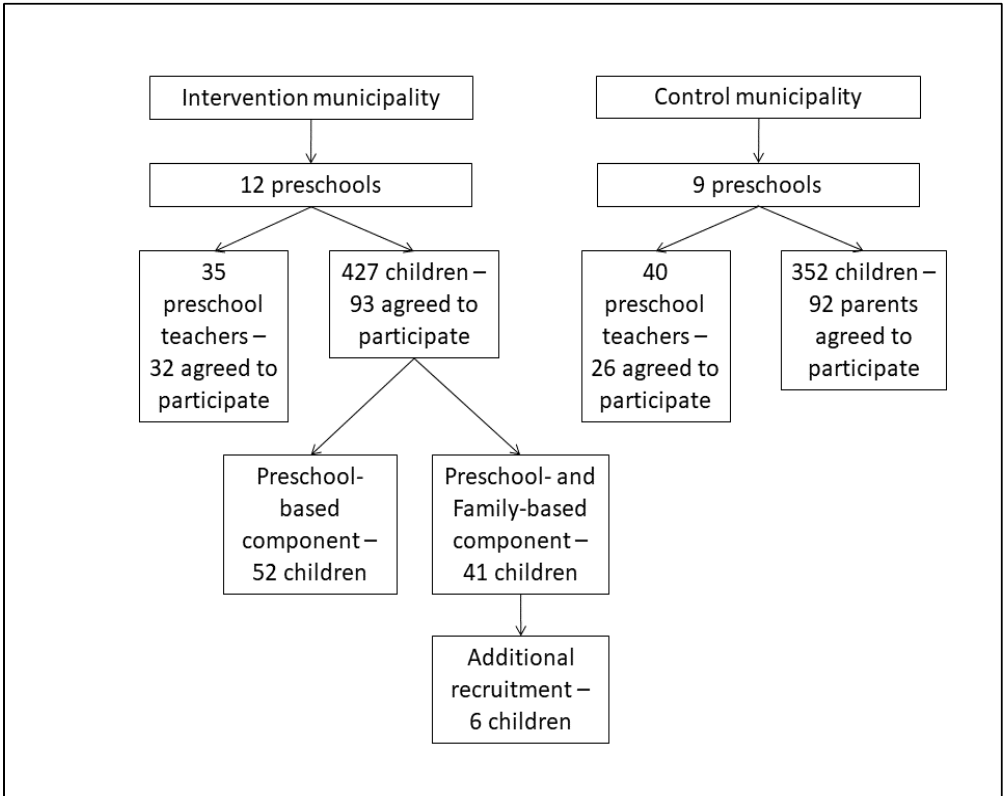
Figure 2. Flow diagram of the participants of SuperFIT.